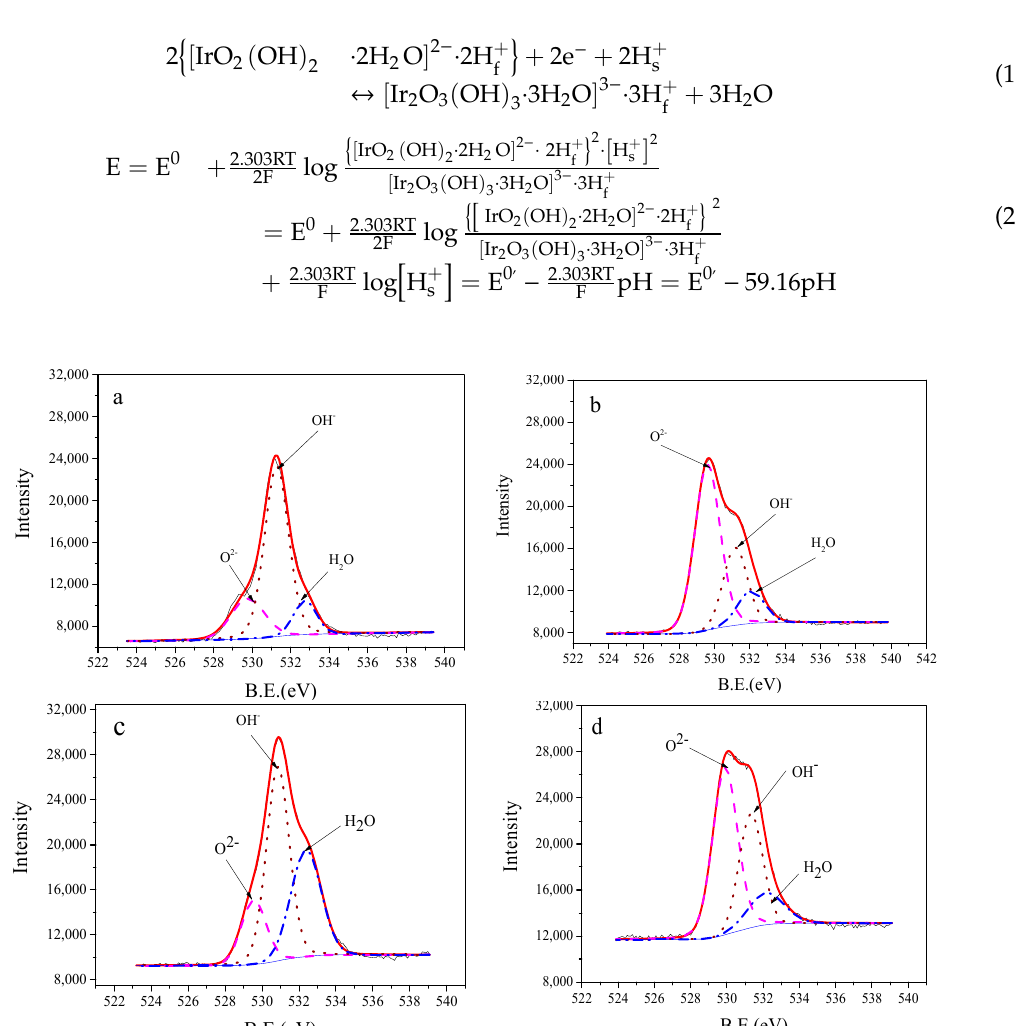
Figure 8. X-ray photoelectron spectra of O1s for IrO X electrodes fabricated at 850 °C: ( a ) freshly ( d ) sample ( c ) after argon-ion etching for 90 s. Table 2. Binding energies and relative contents of different oxygen species, as observed from the O 1s X-ray photoelectron spectra of electrodes fabricated at 850 °C.